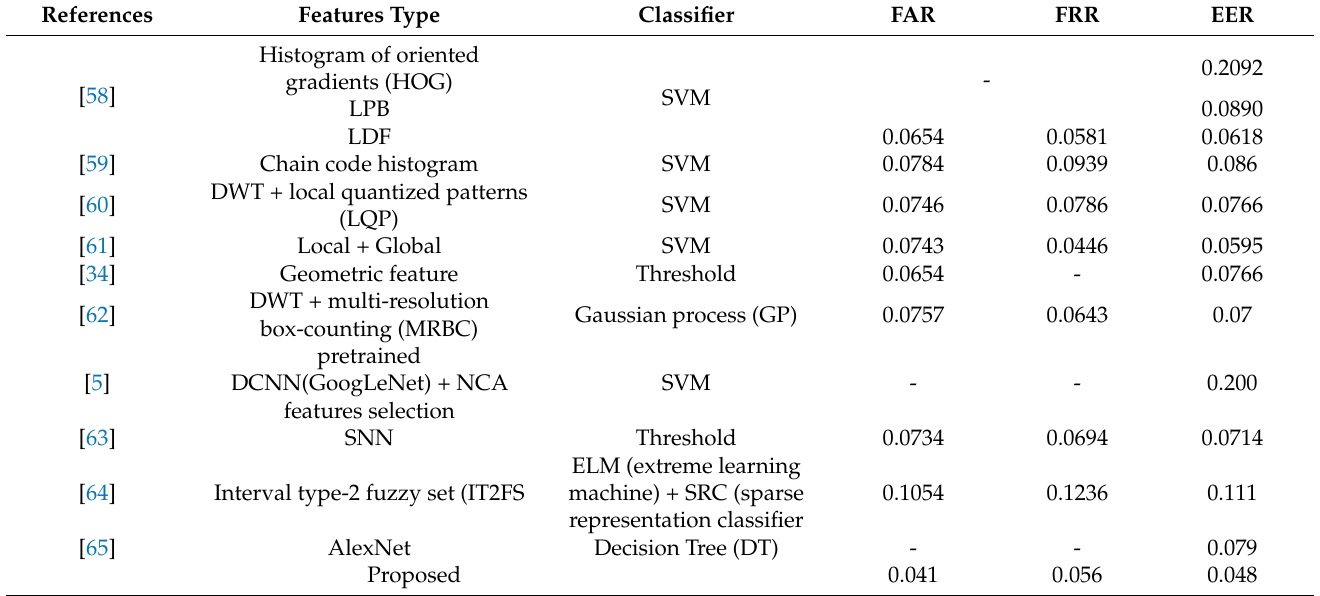
Table 12. Comparison of the results of the proposed approach and the state-of-the-art methods using the CEDAR